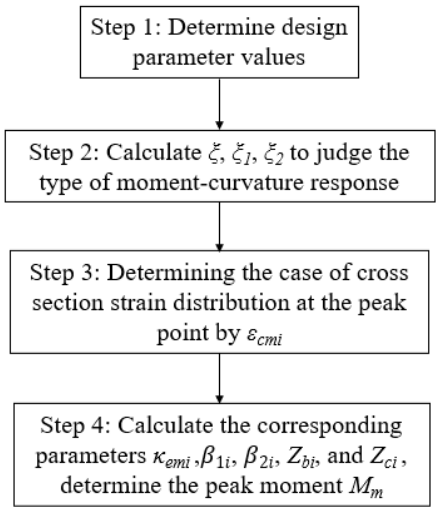
Figure 6. Flowchart of the design procedure for CY